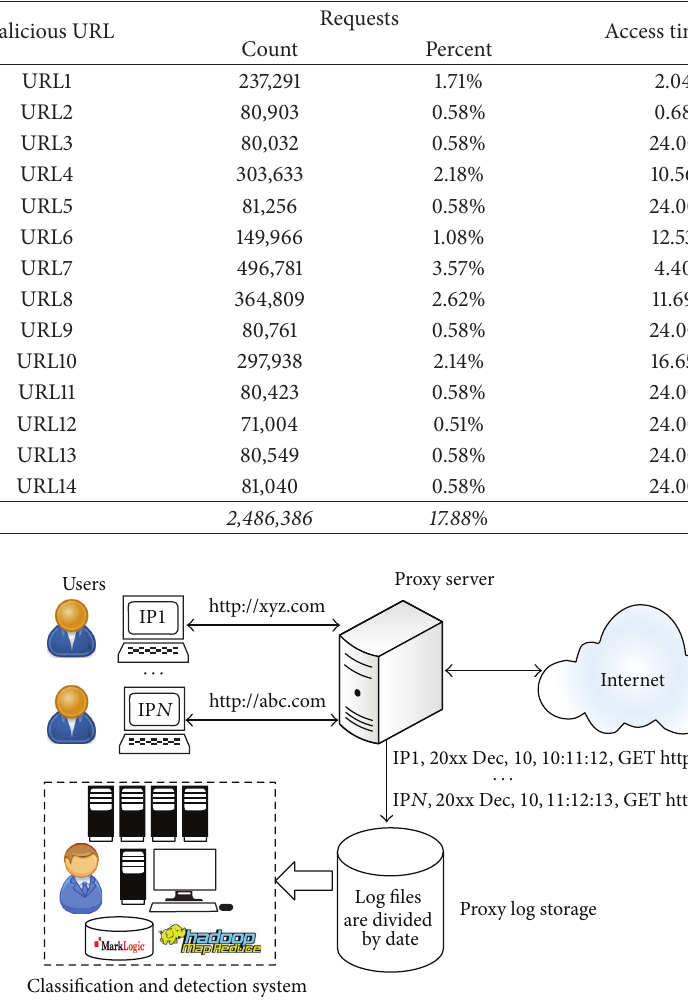
Table 2: Malicious URLs detected in Phase 1 (preprocessing phase).